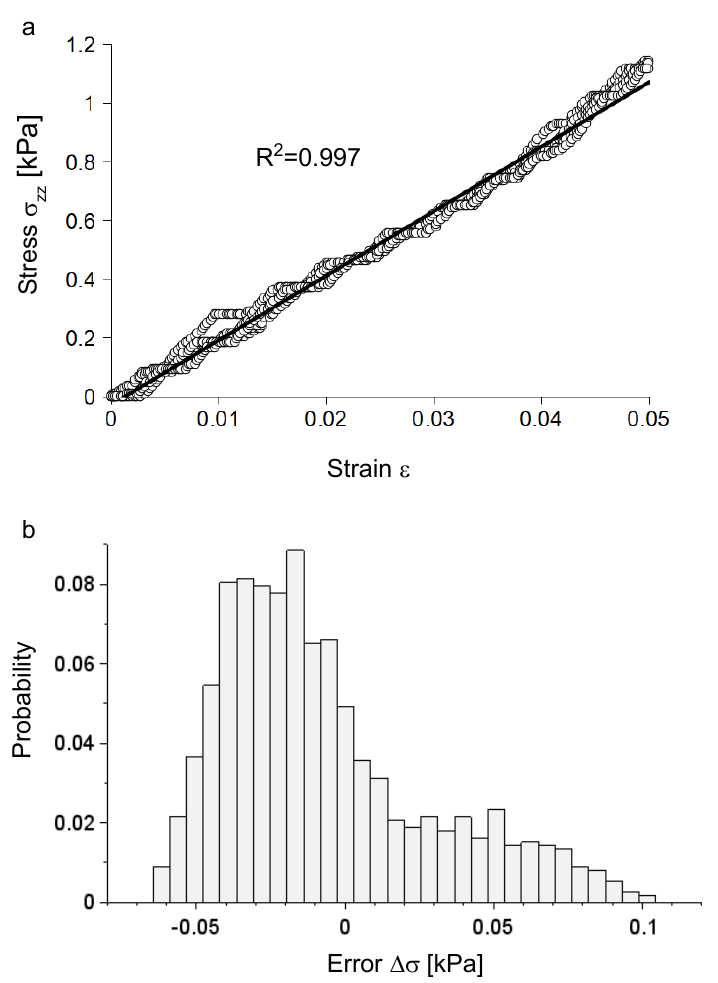
Figure 1. ( a ) Experimental data for five consecutive extensions together with the theoretical prediction (bold line), which was able to closely reproduce the experimental evolution of stress ( R 2 = 0.997). ( b ) The distribution of errors had a peak of probability (around 8.5%) for values ranging between − 0.020 kPa and − 0.015 kPa, while the maximum error was 0.104 kPa (around 0.5%), which represented a deviation from linearity of about